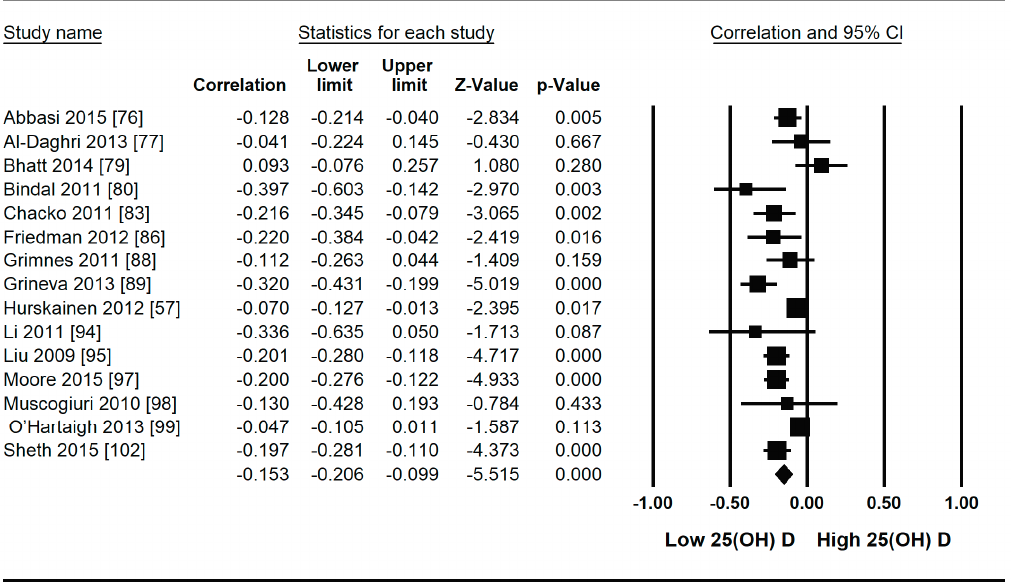
Figure 9. Forest plot for the highest BMI quartile (>30) of non-diabetic subject studies showing the correlation between the status of vitamin D and fasting plasma insulin. The random effects model was used for the determination of correlation and 95% CI [19,36,81,82,84,93]. 3.2.2. Meta-Analysis and Meta-Regression for Diabetes Patient Studies Seven studies fulfilled the criteria to be included in this meta-analysis for the rela- tionship of vitamin D with fasting plasma insulin in diabetic patients. In this meta-analy- sis, we found an inverse association ( r = − 0.255, 95% CI = − 0.392 to − 0.107, p = 0.001)